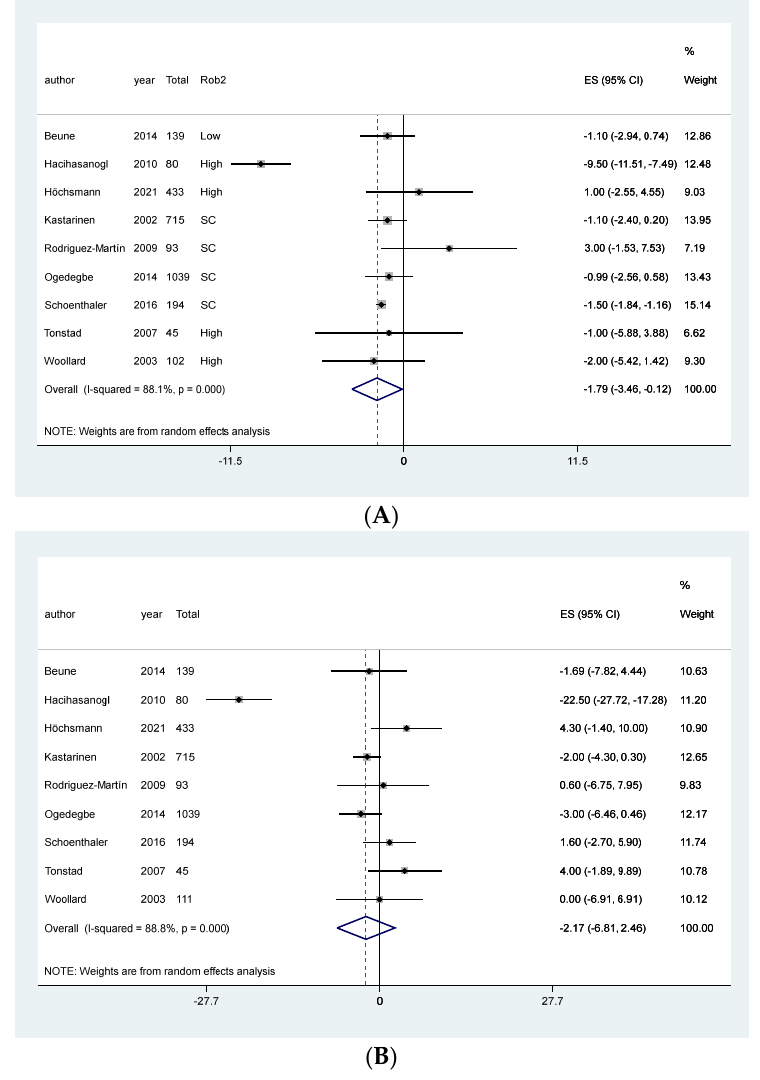
Figure 3. Meta-analysis of the effect of NT on blood pressure in patients primarily diagnosed with hypertension. ( A ) Diastolic blood pressure, ( B ) Systolic blood pressure.